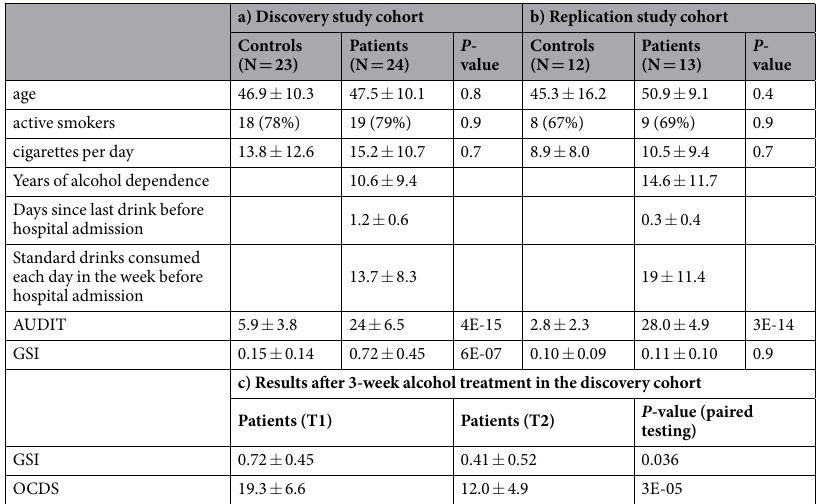
Table 1. Description of a) the discovery study cohort, b) the replication study cohort and c) results after 3-week alcohol treatment program in the discovery cohort. Errors are given as standard deviation. Abbreviations: AUDIT, alcohol use disorder identification test; GSI, global severity index; OCDS, obsessive compulsive drinking